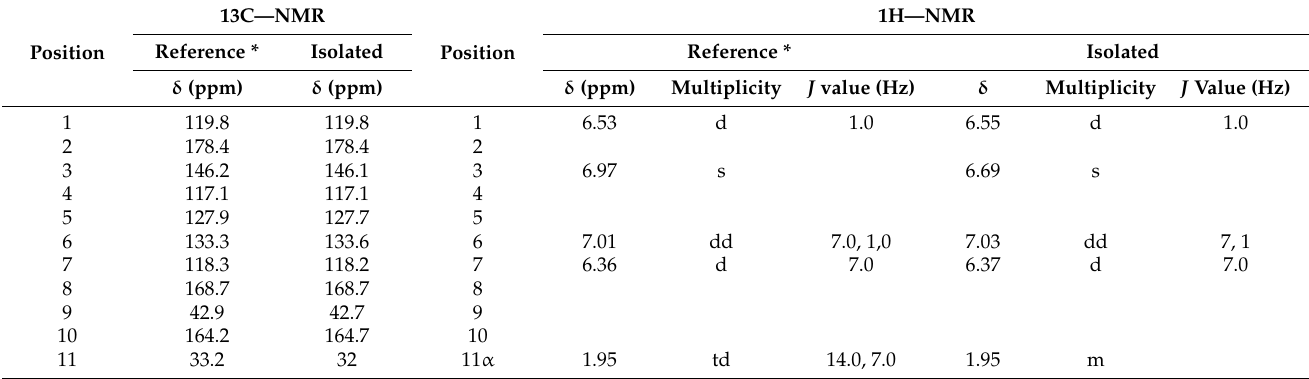
Table 1. Comparison of 13 C and 1 H-NMR spectroscopic data between a previous report and a self-isolation of 20-HM from this